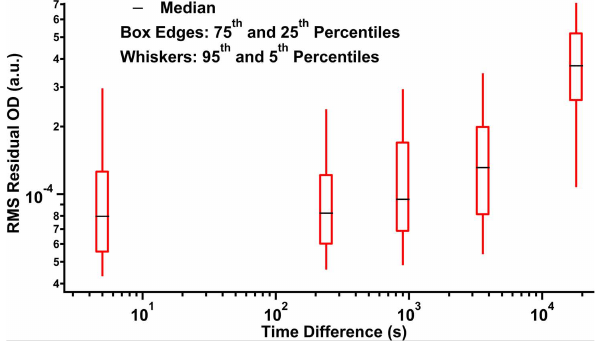
Fig. 6. RMS as a function of time difference between the spectrum analyzed and the reference. The black lines represent the median, the box edges are the 25% and 75% quartiles, and the whiskers are the 5% and 95% quartiles. In general, using a reference taken close in time to the spectrum analyzed provides better RMS